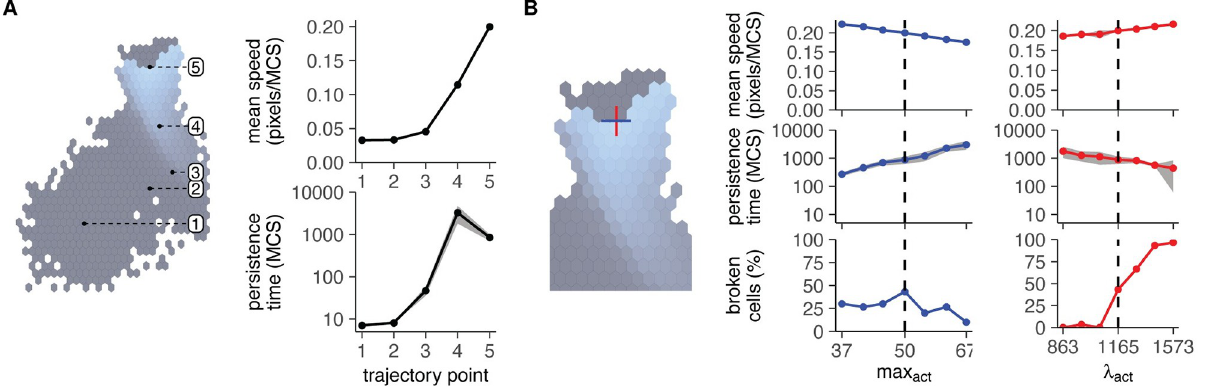
Fig 3. Evolution of optimal search in Act cells is subject to constraints and trade-offs. A: Speed and persistence measured at different points in the fitness landscape of Fig 2C. B: Speed, persistence, and cell breaking measured around the evolved optimum (max act = 50, λ act = 1165).